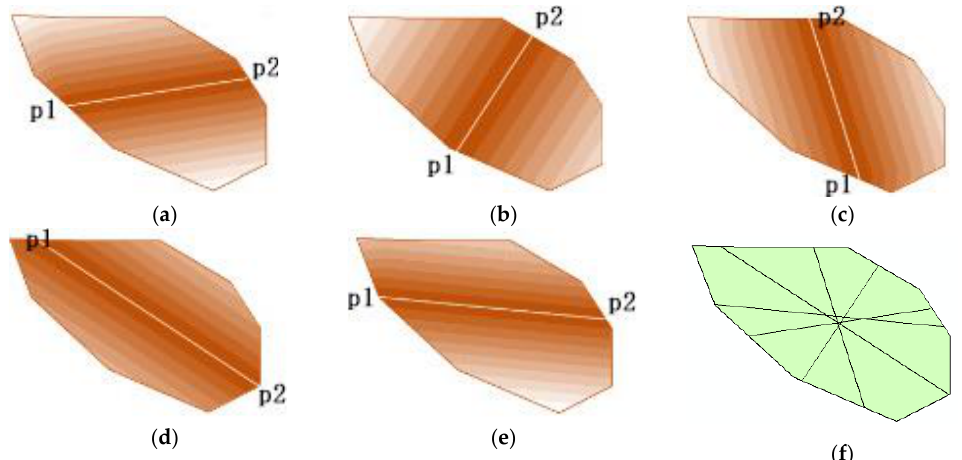
Figure 6. Five different centroid balance lines for the same polygon P : ( a – e ) result of the Euclidean distance transformation of five different centroid balance lines; ( f ) the overlapping results of the five centroid balance lines.